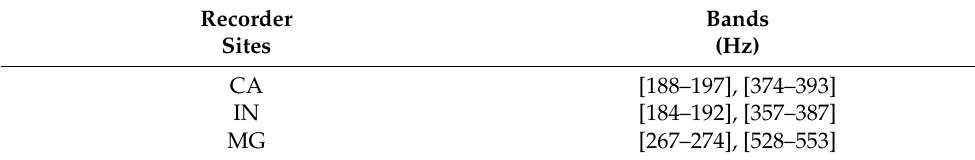
Figure 8. Empirical SPL histograms for 1/3-octave bands (base 10 center frequencies (Hz), and broadband—bottom right) between 40 and 1000Hz, using 1 s time slots with 50% overlap, between 14:00 and 20:00 UTC in June 2018 for recorder location CA at 484m depth: recorded data (red), shipping and wind model generated data (blue) and spatial weighted calibrated data (green) (Axes: probability density (y) in 1 dB re µ Pa, SPL bins (x)). Table 1. Recorder’s self-noise filtered